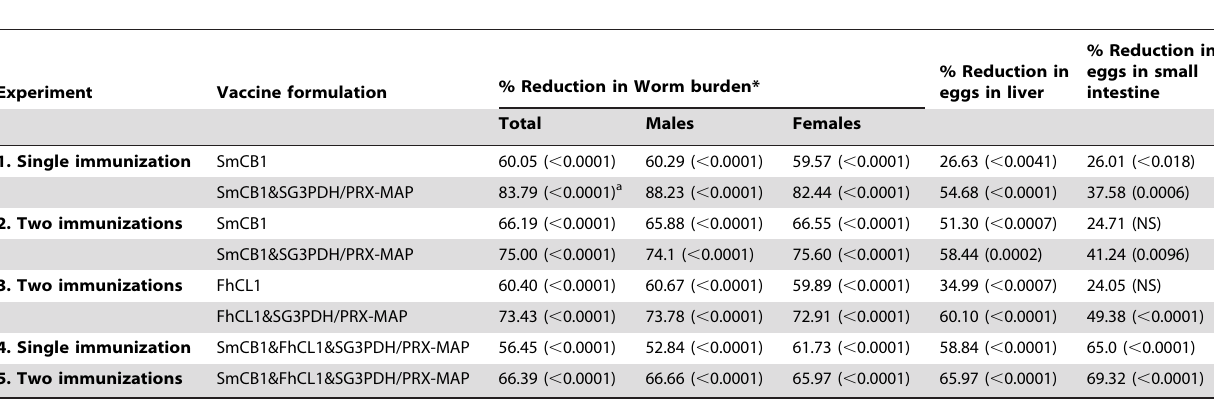
Table 1. Protective effects of immunization with C-1 peptidases SmCB1 and FhCL1 alone and in combination with SG3PDH/PRX- MAP on male and female worm burdens and parasitological